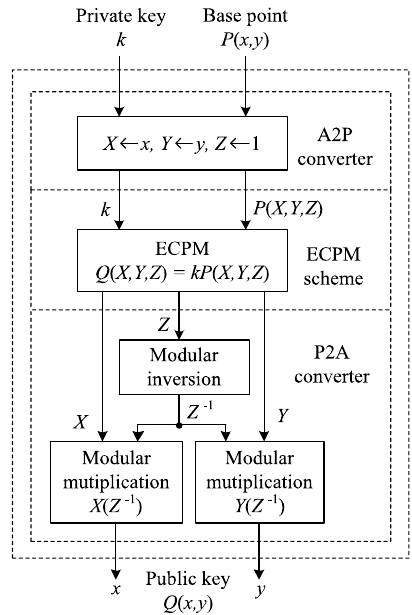
Figure 8. Proposed ECC processor for public-key